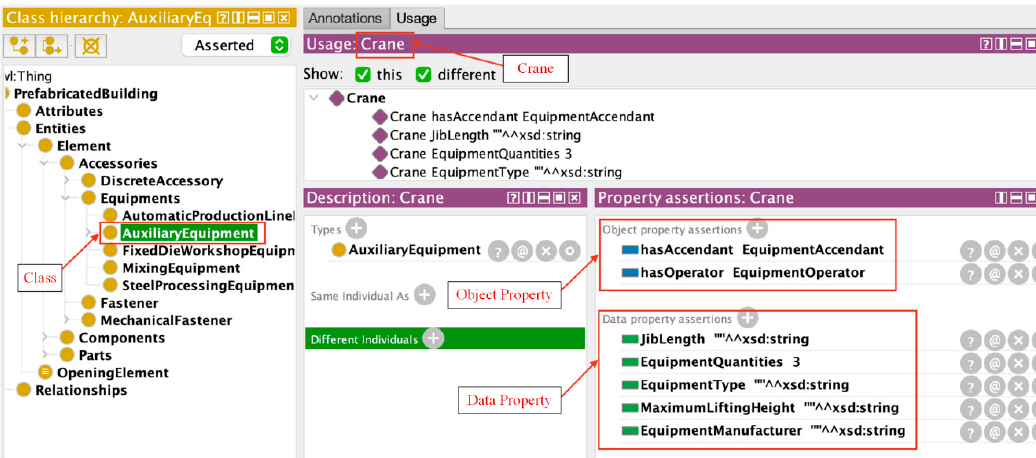
Figure 23. Auxiliary device individual creation.